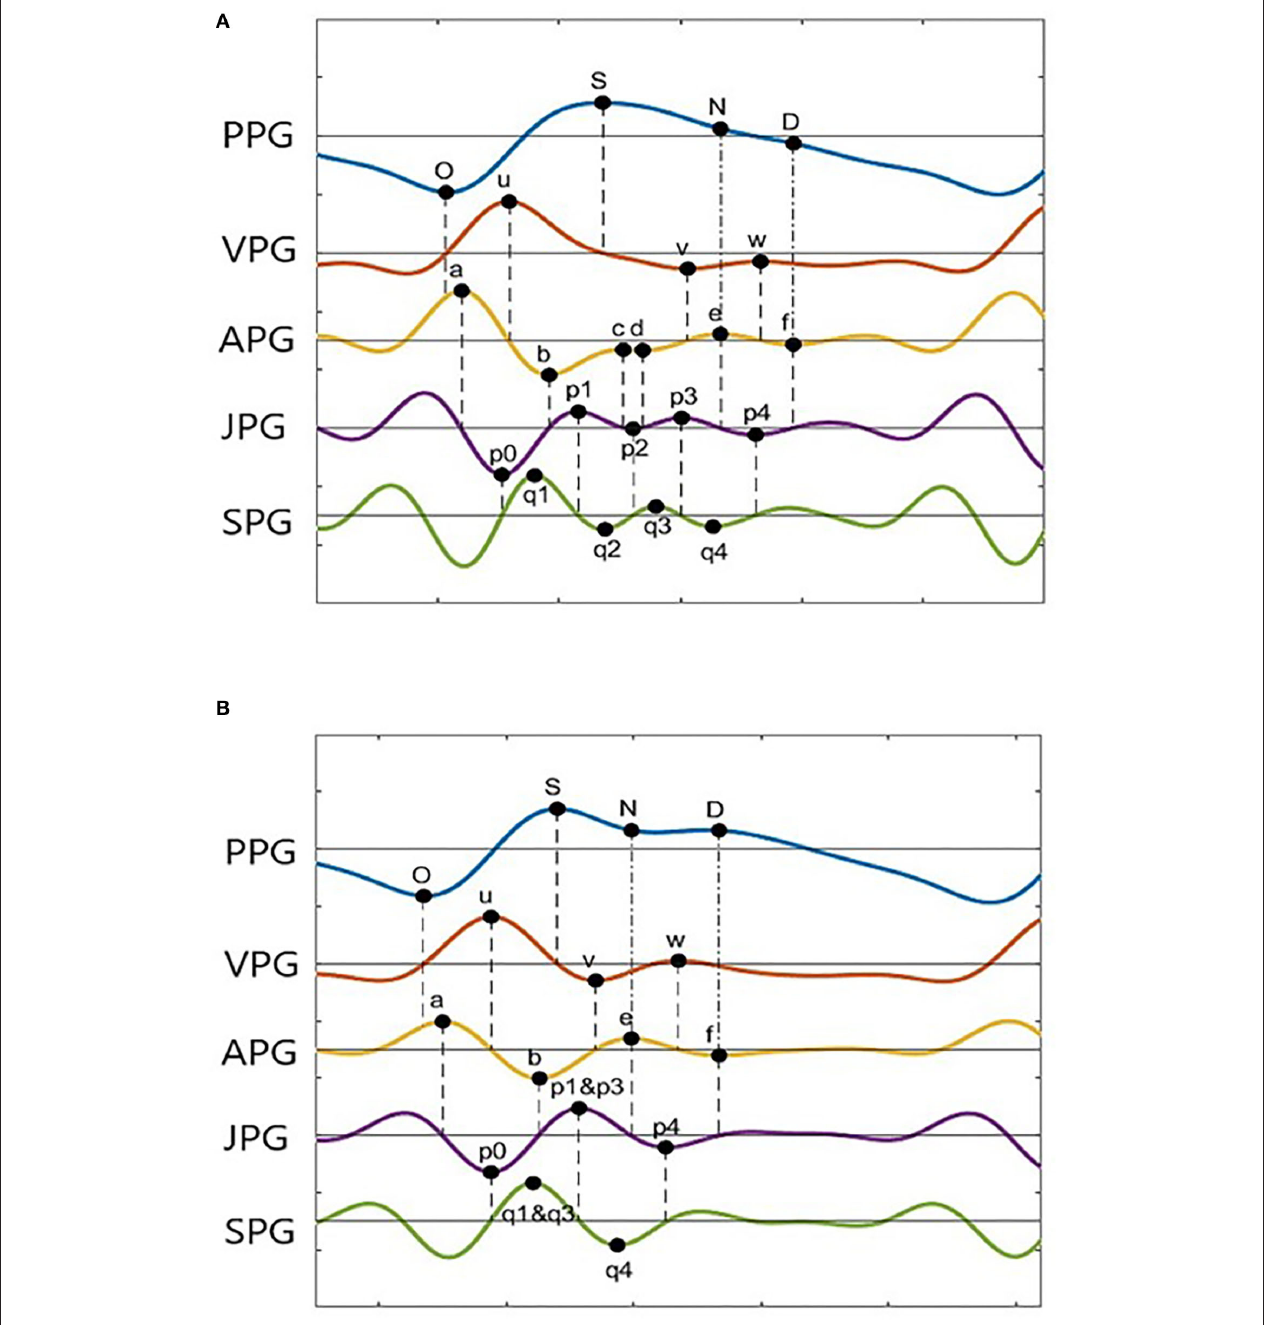
FIGURE 3 | PPG derivatives marker from two typical morphologies of PPG (A) Type I, (B) Type